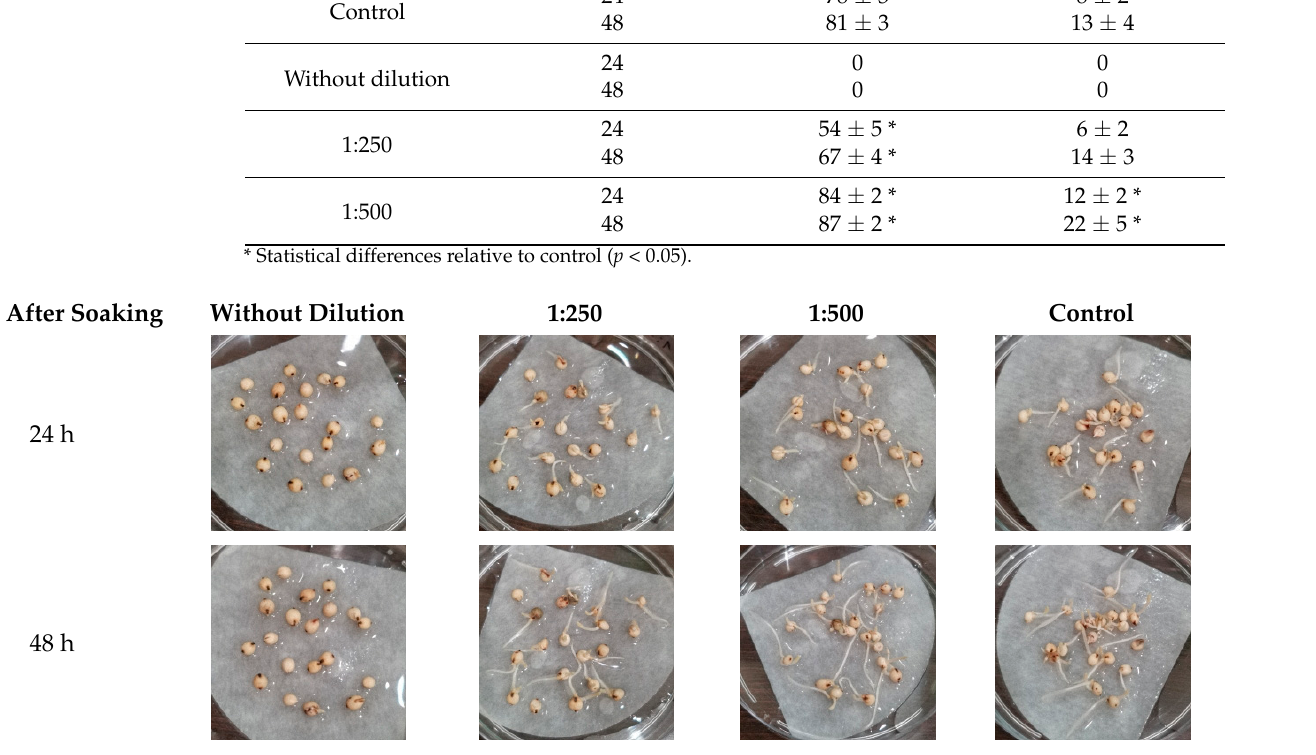
* Statistical differences relative to control ( p < 0.05).